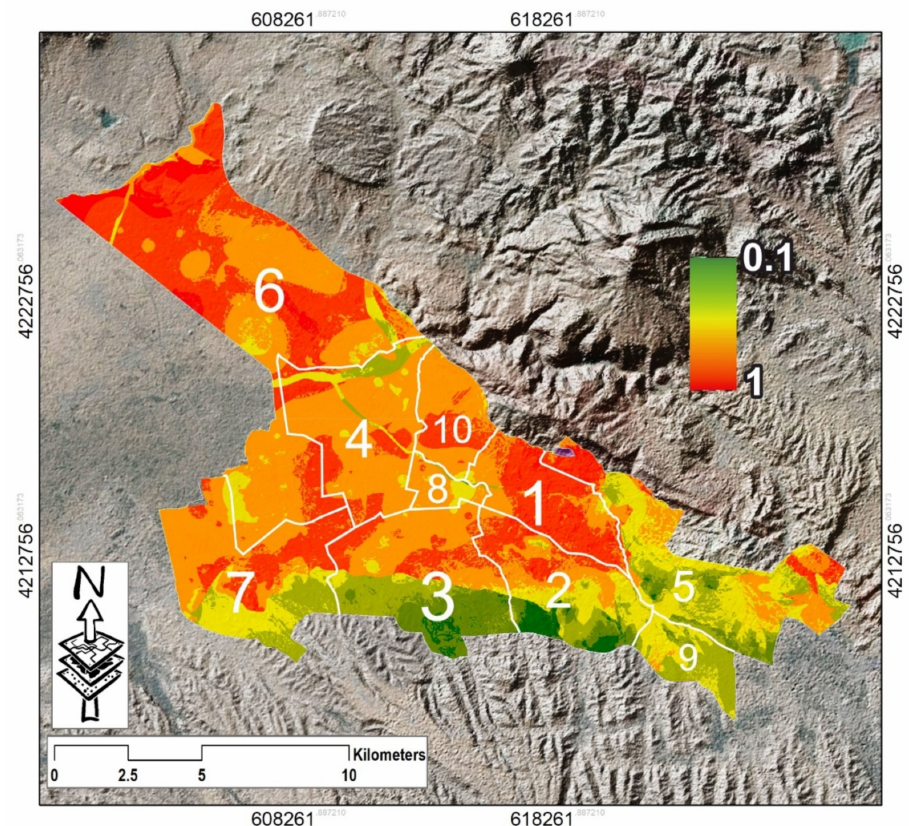
Figure 6. Seismic amplitude map. The numbers are municipal areas of the